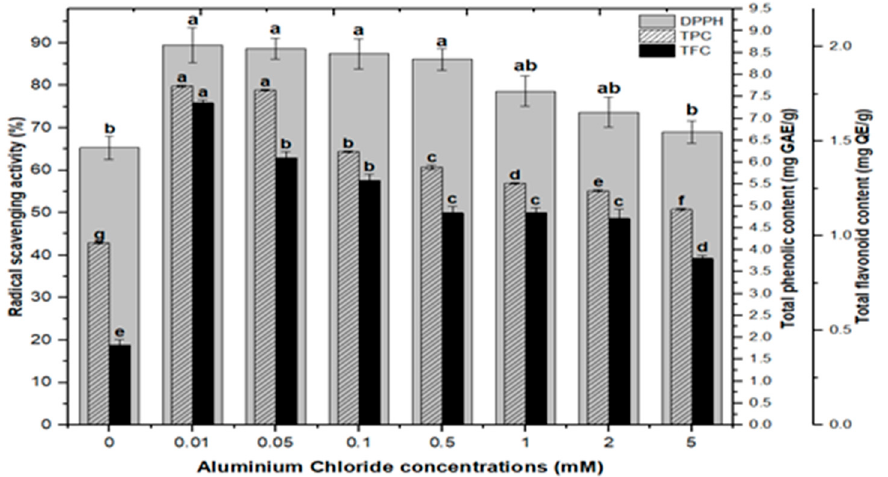
Figure 9. Radical scavenging activity (DPPH %) in comparison with total phenolic contents (TPCs) and total flavonoid contents (TFCs) (correlation ‘r’ DPPH vs. TPC = 0.815 and DPPH vs. TFC = 0.838) in F. indica callus culture elicited with seven different concentrations of aluminum chloride along with control. Bars labeled with different letters (LSD values) exhibit significant variation ( α < 0.05).